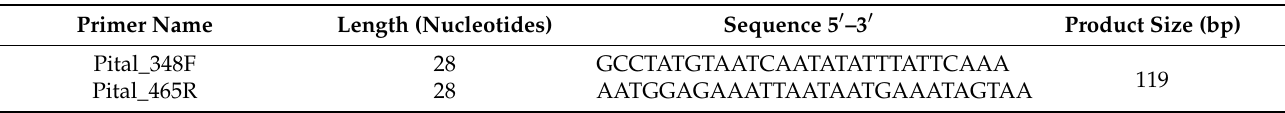
Table 6. List of the primers used in the SYBR Green